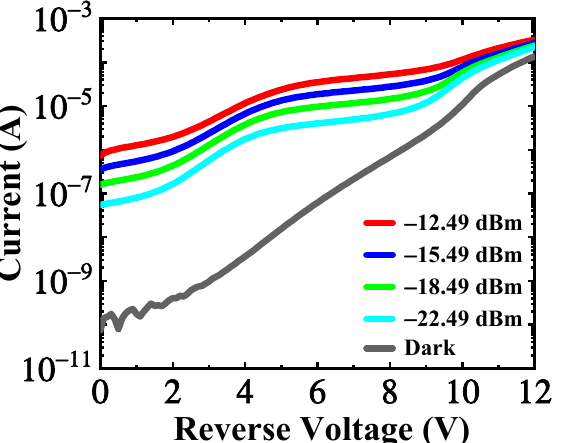
Figure 6. The dark current and photocurrent under different incident optical power are the function of reverse voltage.